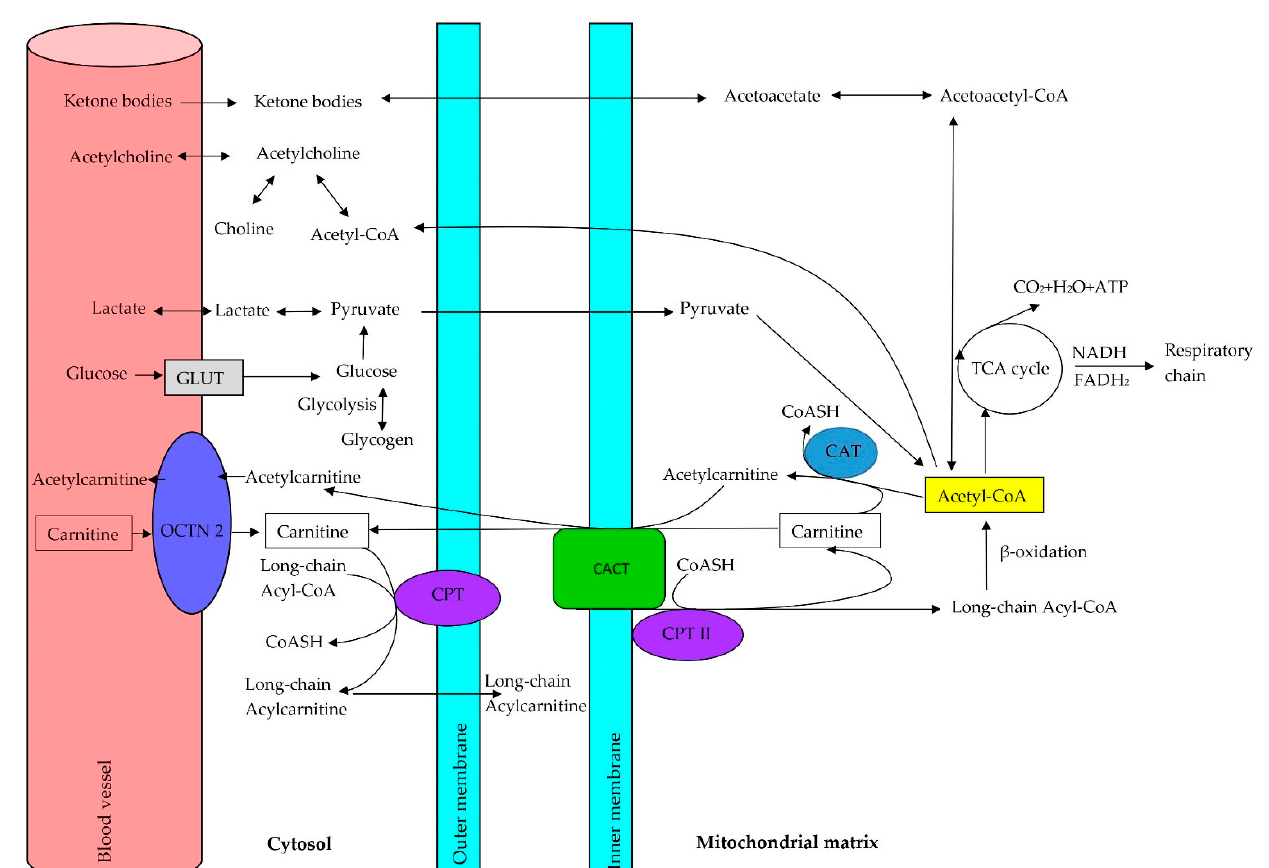
Figure 2. Metabolic roles of carnitine and other substances in the brain. Abbreviations: GLUT, glucose transporters; OCTN2, sodium-dependent carnitine organic cation transporter; CPT I, carnitine palmitoyltransferase I; CPT II, carnitine palmitoyltransferase II; CACT, carnitine-acylcarnitine translocase; CAT, carnitine acetyltransferase; CoASH, coenzyme A; Acetyl-CoA, acetyl coenzyme A; TCA cycle, tricarboxylic acid cycle.